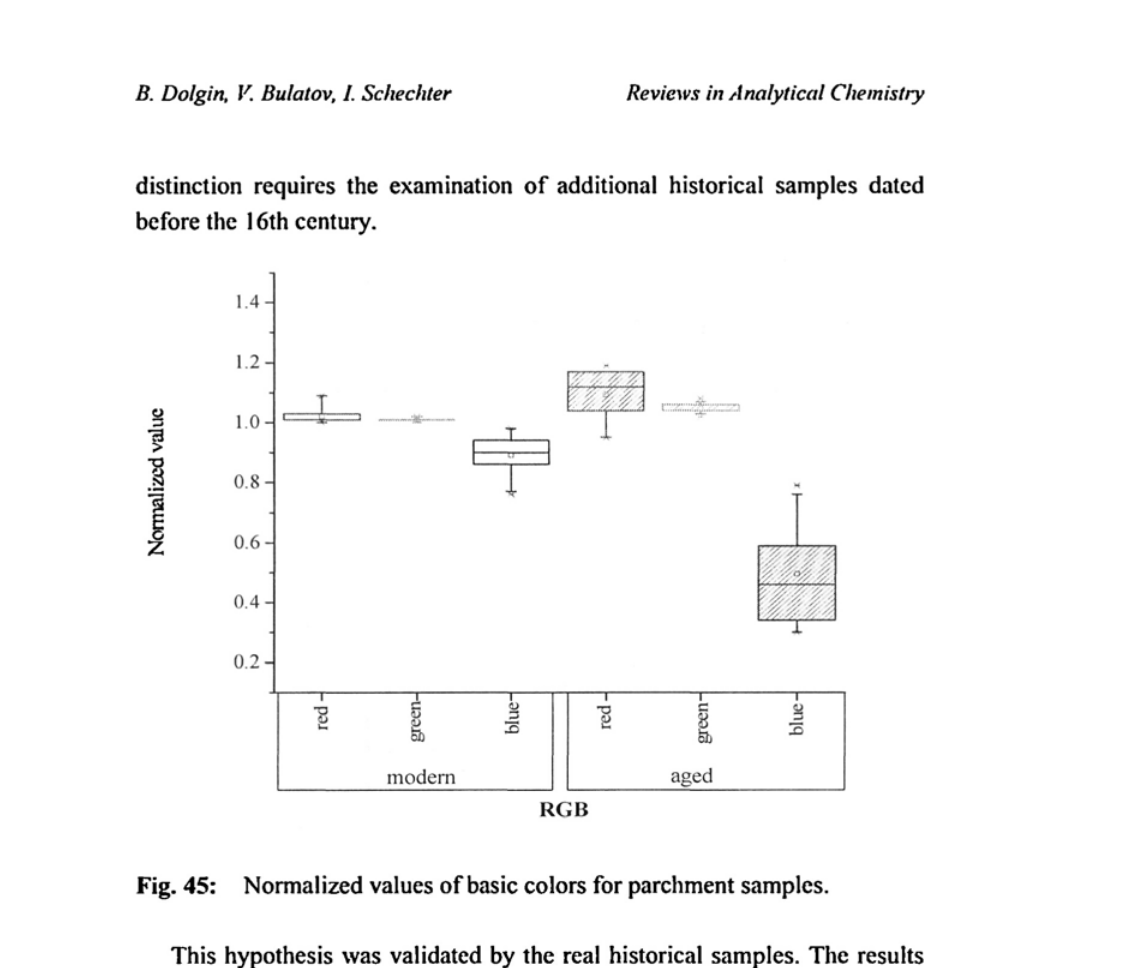
Fig. 45: Normalized values of basic colors for parchment